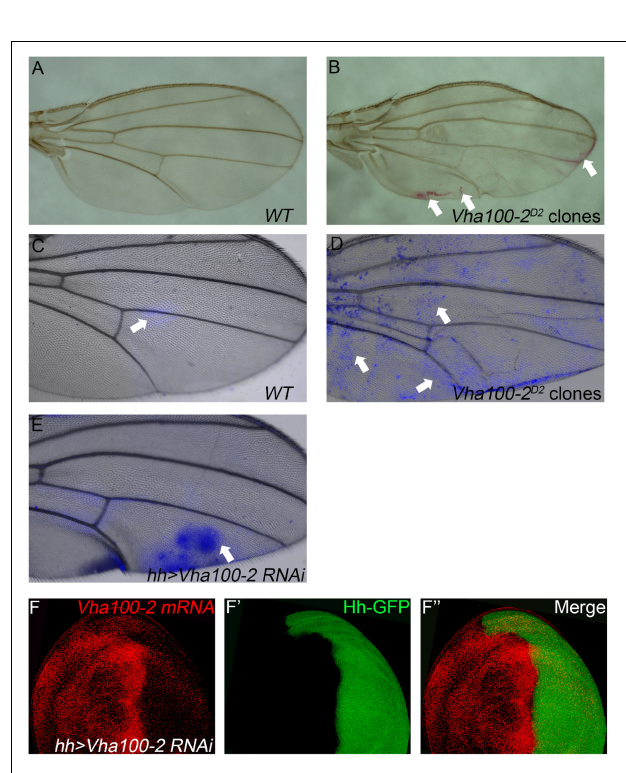
FIGURE 3 | Vha100-2 is specifically required for wing cuticle formation. (A,B) Penetration of Eosin Y through the wing cuticle. The adult wing of Ubx-FLP; FRT82B, Ubi-RFP stock is used as wild type control, which is resistant to Eosin Y penetration (A) . By contrast, patches with Eosin Y staining (red) are observed in fly wings harboring homozygous Vha100-2 D2 mutant clones (B) . (C–E) Penetration of FB28 through the wing cuticle. In wild-type control wings, the FB28 dye (blue) shows limited penetration competency (C) . The FB28 dye (blue) scatters into the wing bearing homozygous Vha100-2 D2 clones (D) . In Vha100-2 RNAi expression area, the penetration of the FB28 dye (blue) is evident (E) . (F) The mRNA level of Vha100-2 (red) are down-regulated in RNAi expressing cells (marked by GFP). Representative Eosin Y and FB28 staining patches are indicated by arrows. The down-regulation of Vha100-2 in RNAi expressing region is fully penetrant ( n = 7). Scale bars: 0.5 mm in (A–E) and 10 µ m in (F) .